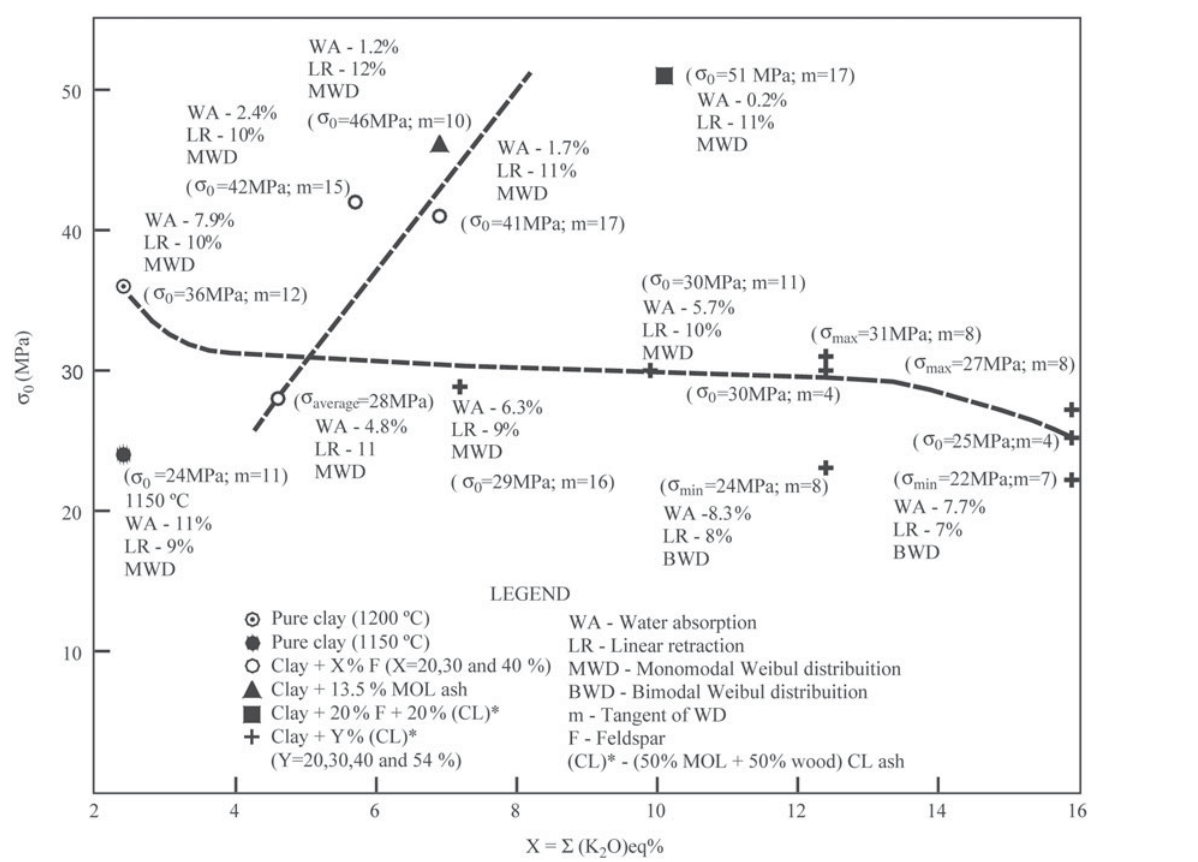
Figure 8. Weibull distribution parameters ( σ